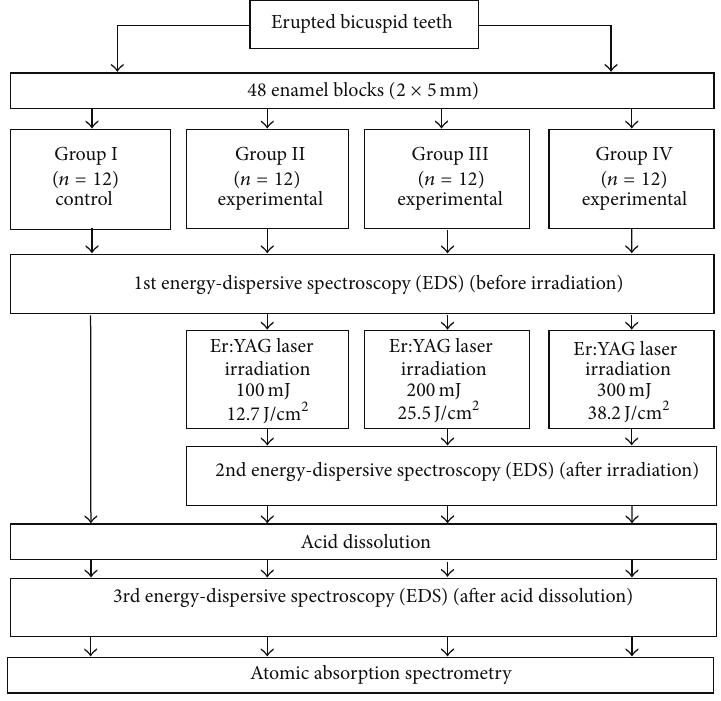
Figure 1: Diagram of the experimental